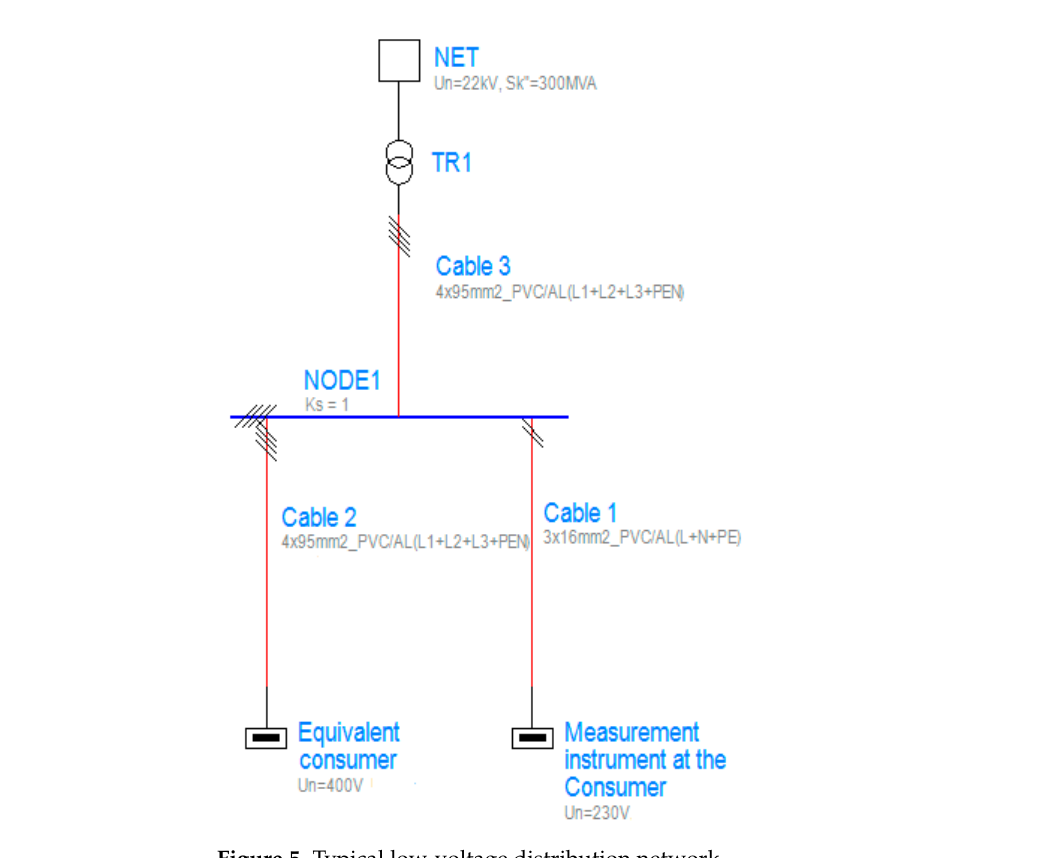
Figure 5. Typical low-voltage distribution network. The network component parameters are depicted in Table 4. Table 5. The 100-kVA transformer and L = 10 m for cable Table 4. Purely resistive network.